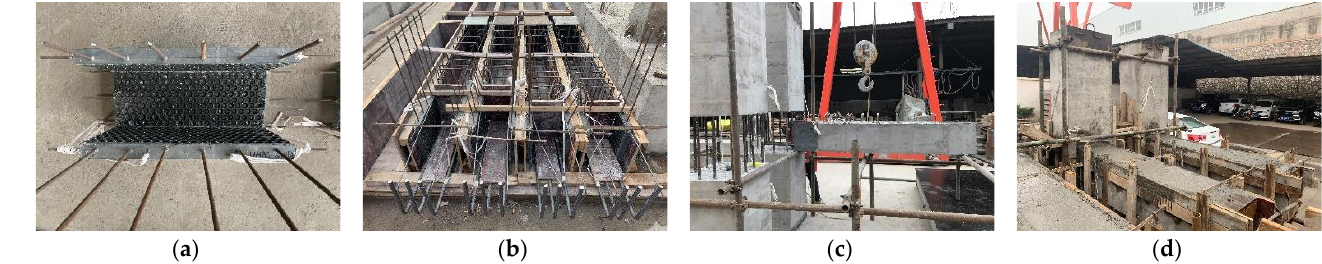
Figure 3. Manufacturing of the precast specimens. ( a ) Making UHPC shells, ( b ) fabricating beams, ( c ) installing beams, ( d ) pouring concrete.